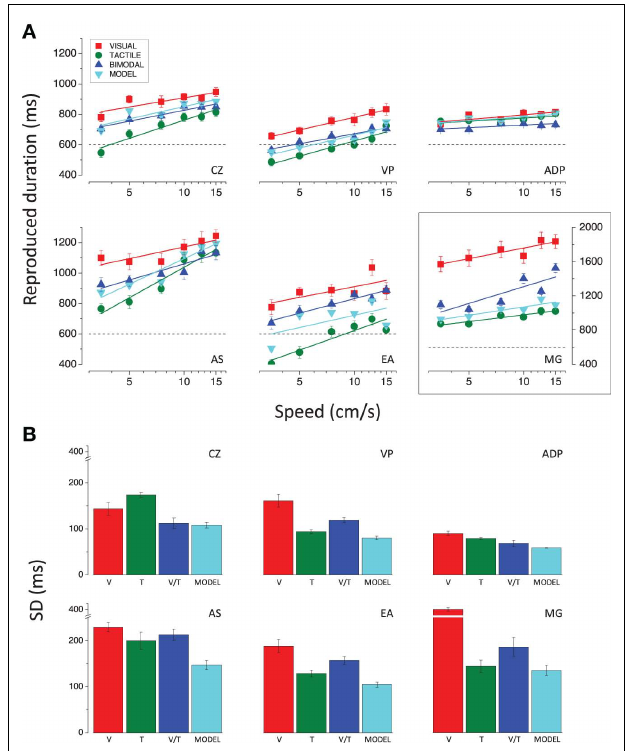
FIGURE 5 | (A) Reproduced durations for the 600ms stimuli, plotted as a function of speed for all conditions.The results for the subject MG have been plotted on a different scale to encompass her wider range of duration estimates. (B) SDs of the reproduction averaged across speeds relative to the 600ms visual (red bar), tactile (green bar), and bimodal (blue bar) stimuli and predicted for bimodal stimuli according to the Bayesian model (cyan bar); results for all subjects.